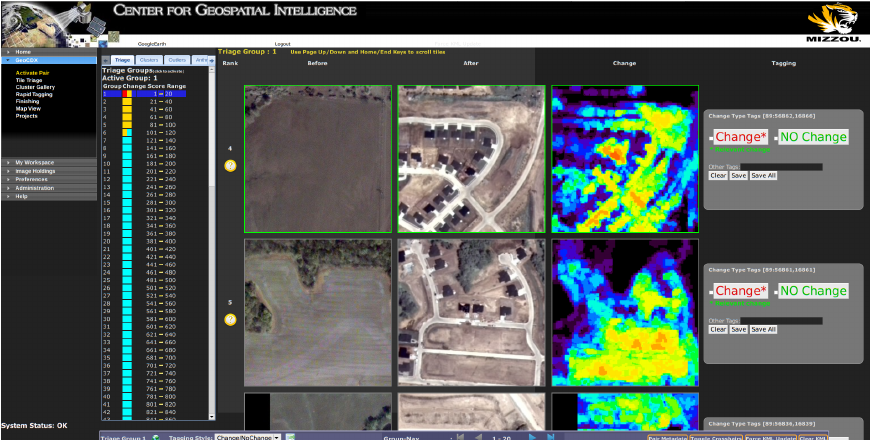
of change detection results in batches of twenty tiles ( i.e. , 1–20, 21–40, etc .). Further to the right are three images in each row representing the before image, the after image and the corresponding change map that highlights changed regions. Finally, on the far right side of each row, there is a UI element that allows an analyst to tag a tile as “change” (the button with the red text) or “no change” (the button with the green